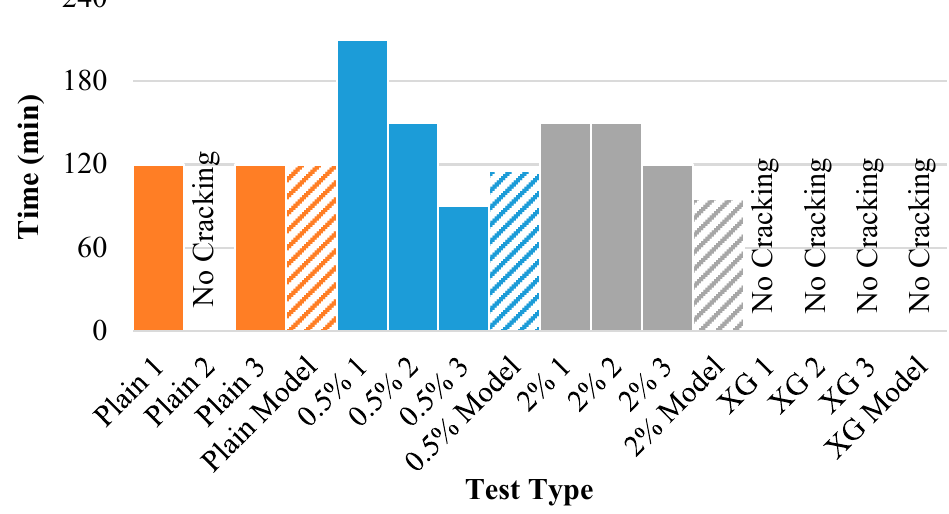
Figure 16. Wall crack time for each of the experiments and model results.